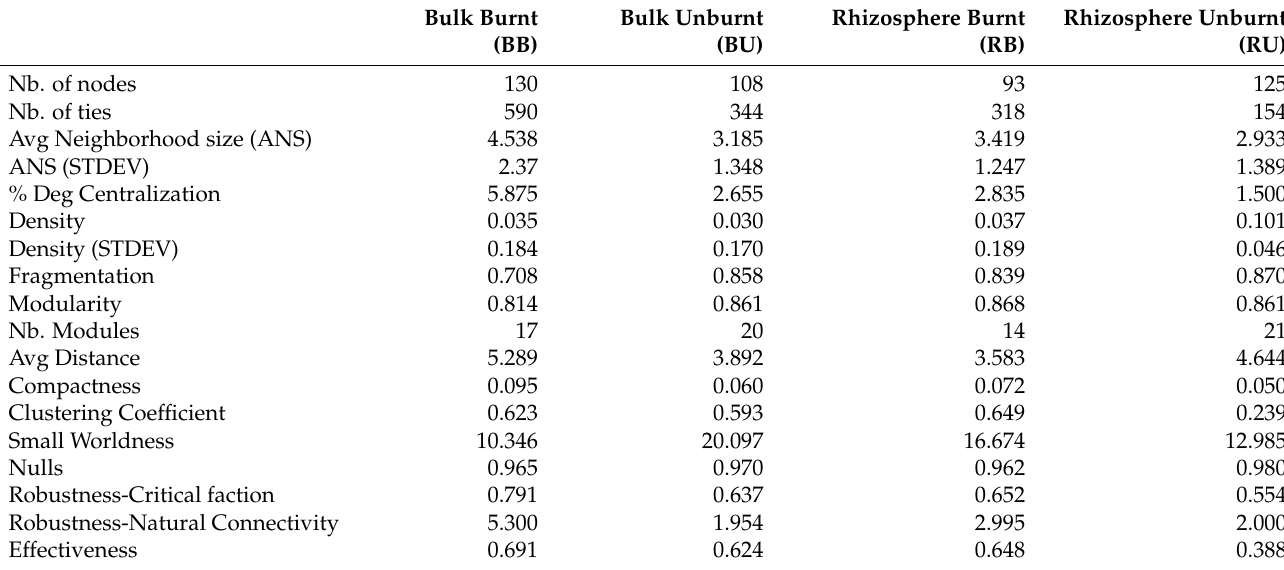
Table 2. Co-occurrence network properties for networks corresponding to each sampling site. For the description of parameters, see Table S1 (STDEV = standard